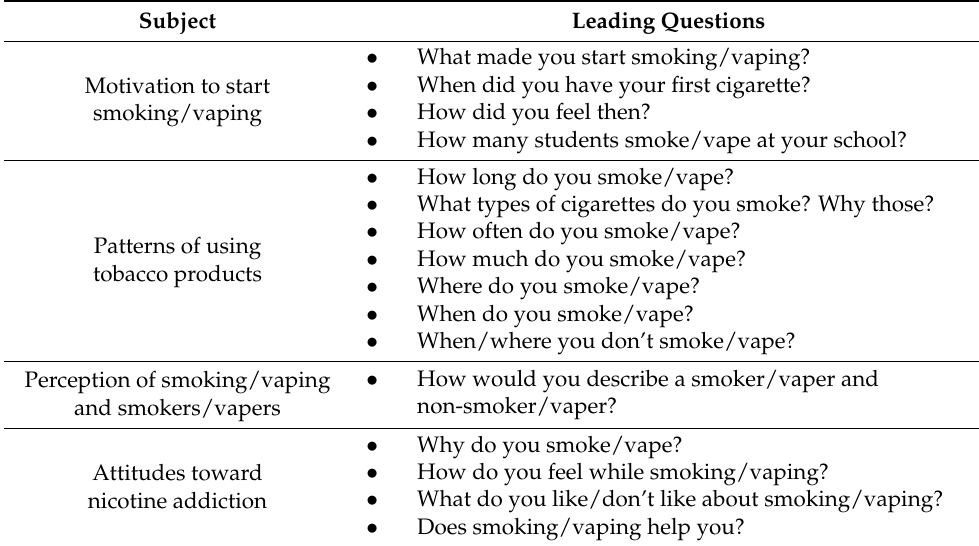
Table 1. Examples of questions asked during the